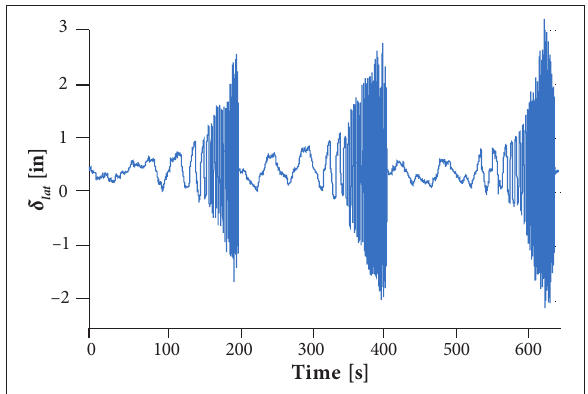
Figure 10. Concatenated lateral control inputs – level flight (80